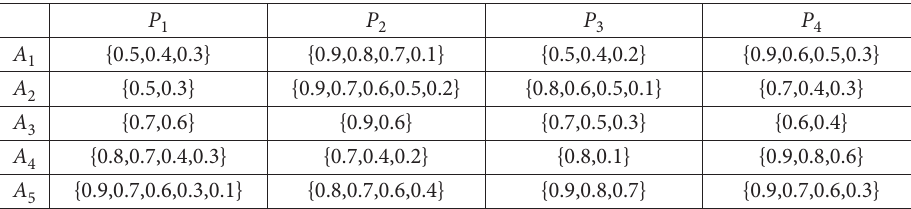
Table 1. Hesitant fuzzy decision